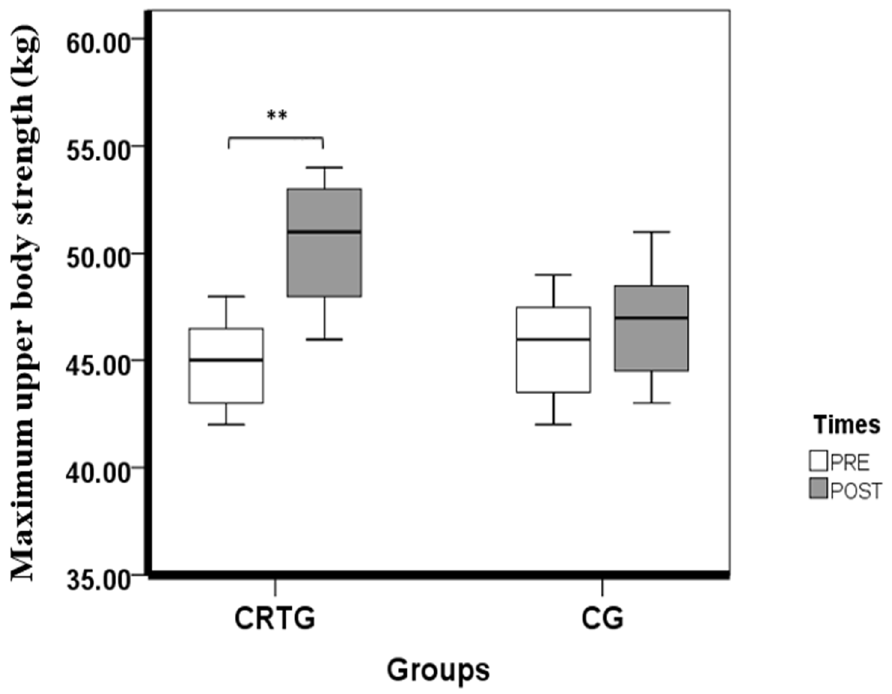
Figure 2. Box plots displaying the 25th and 75th percentiles, medians and whiskers extending from the minimal to maximal for the maximum upper body strength (bench press) in both groups (CRTG and CG) after 9 weeks of training. (** p < 0.01).